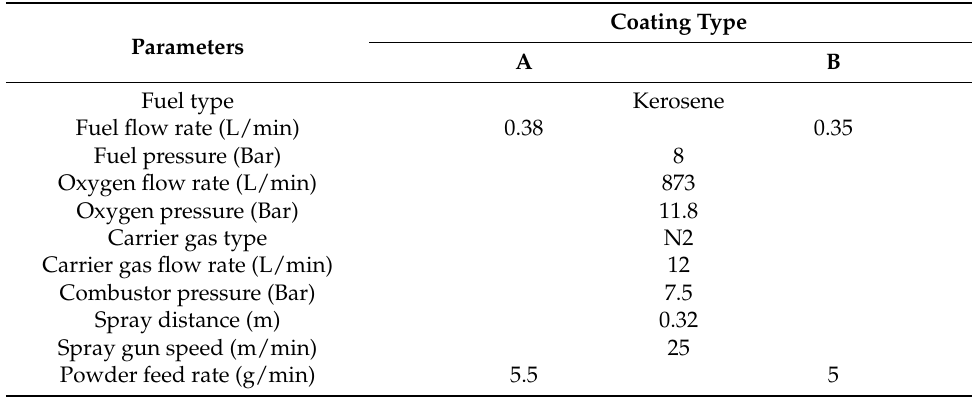
Table 2. Process parameters employed for HVOF spraying